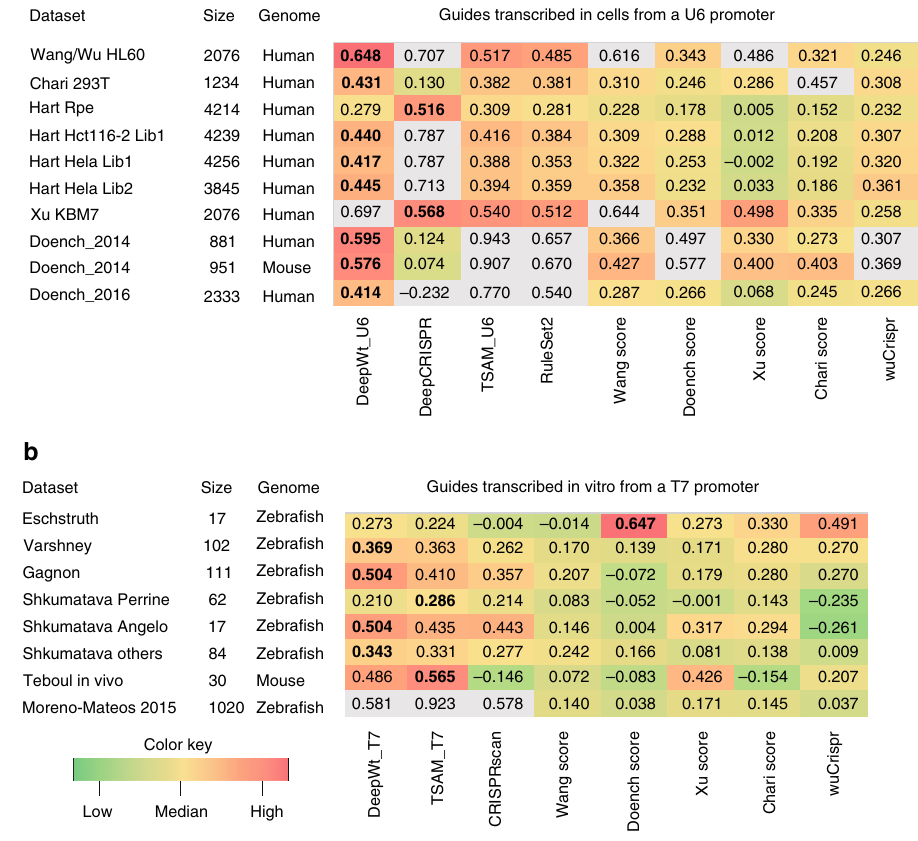
Fig. 7 Heatmap of Spearman rank correlation coef fi cients between ef fi ciency scores and data sets. a gRNAs transcribed in cells from a U6 promoter. b gRNAs transcribed in vitro from a T7 promoter. Cell type, the number of gRNAs, and species are shown on the left. Scores are shown along the horizontal axis, data sets on the vertical. Correlations of an algorithm against its own training data set are shown in gray as they are likely to be overestimated due to over- fi tting. The highest scores are in